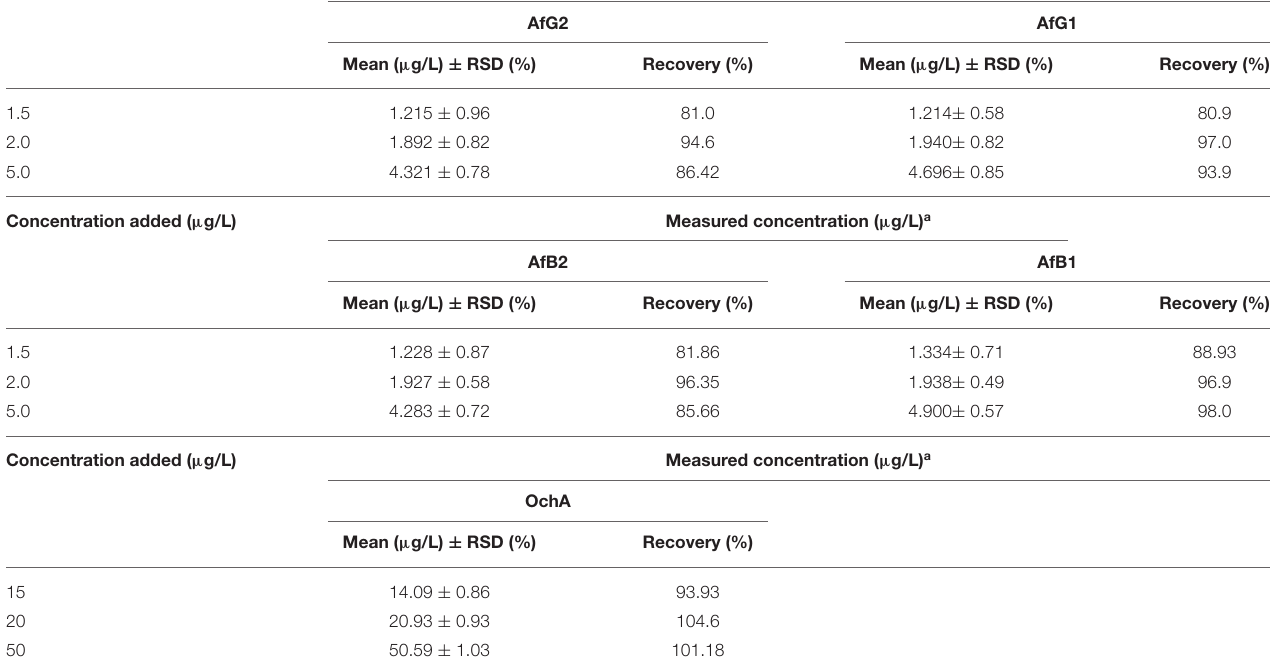
TABLE 4 | Precision and accuracy of the method. Concentration added ( µ g/L)